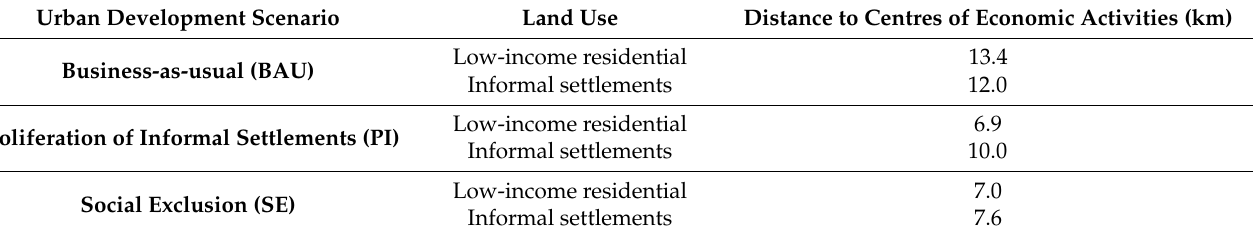
Table 7. Comparison of commuting distances between